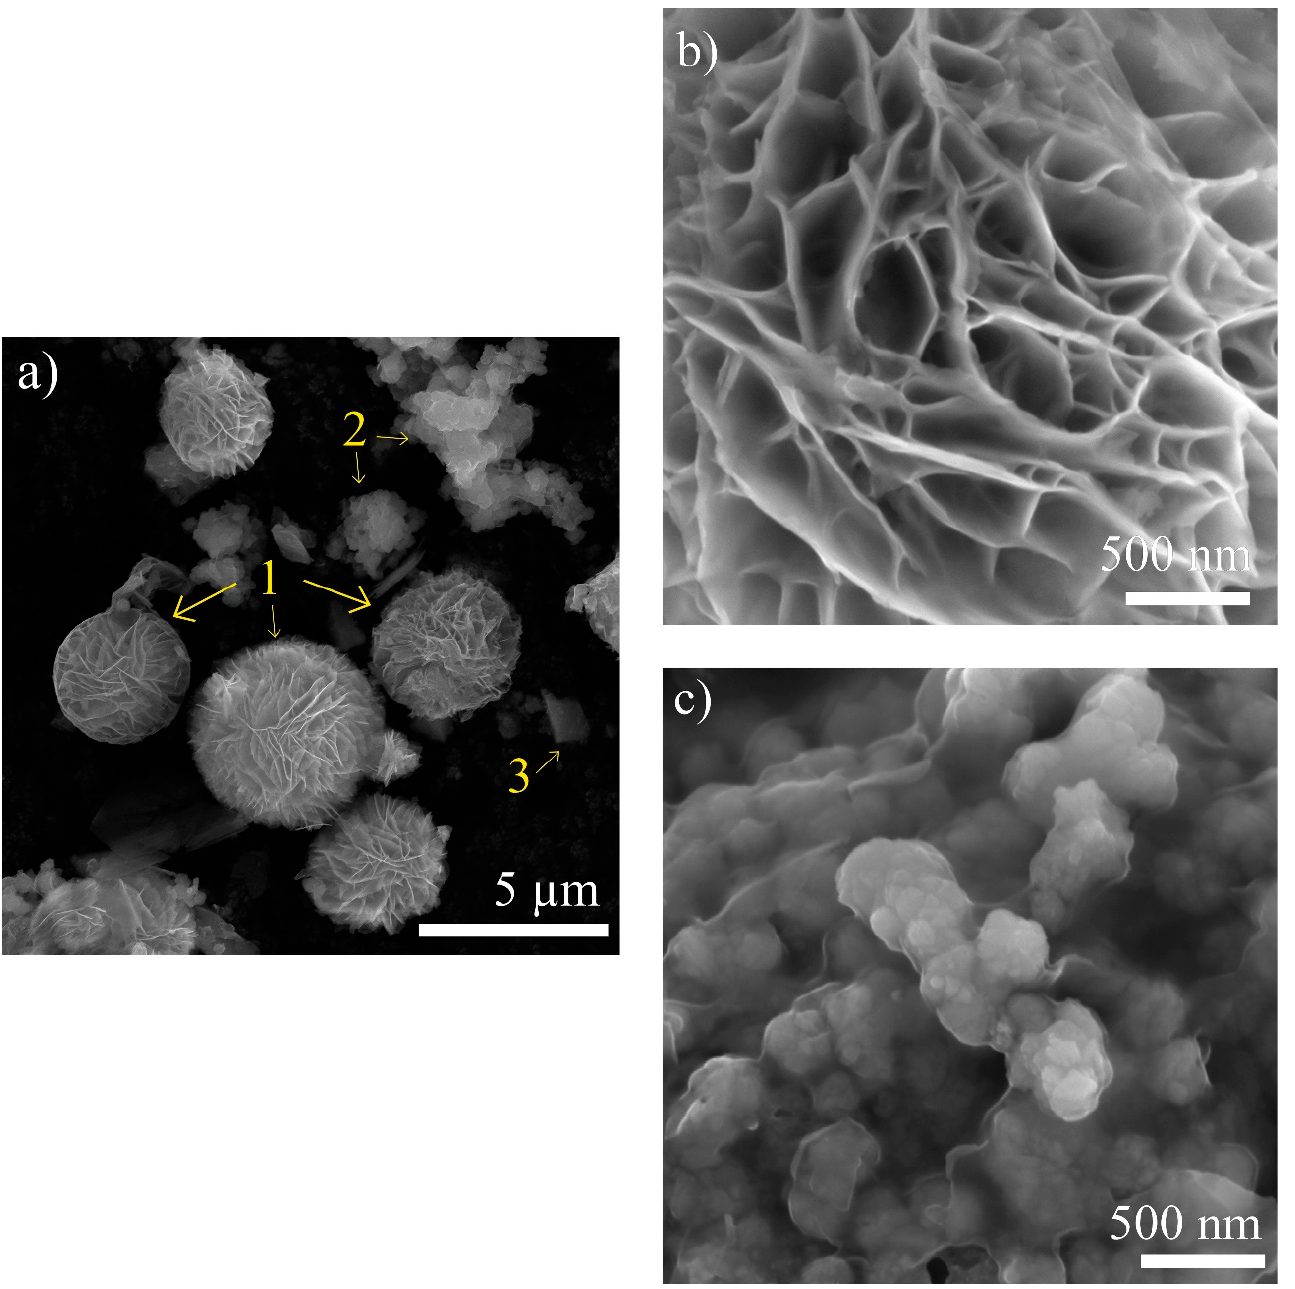
Figure 5. SEM images of the ( a ) P-180 product illustrating both morphologies, ( b ) flower-like architecture and ( c ) aggregates of nanoparticles.